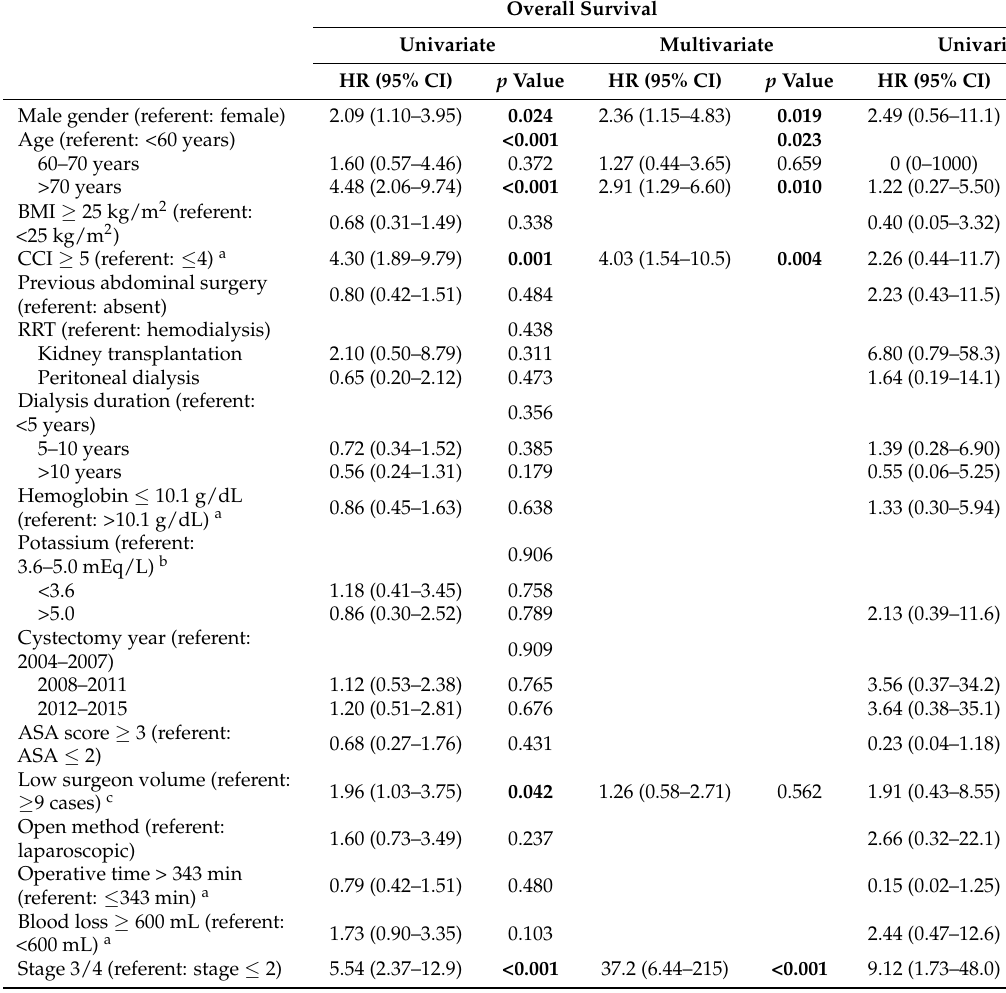
Table 5. Univariate and multivariate analysis of potential prognostic factors for overall, cancer-specific, and recurrence-free survival in dialysis patients undergoing radical cystectomy. Overall Survival Cancer-Specific Survival Recurrence-Free Survival Univariate Multivariate Univariate Multivariate Univariate